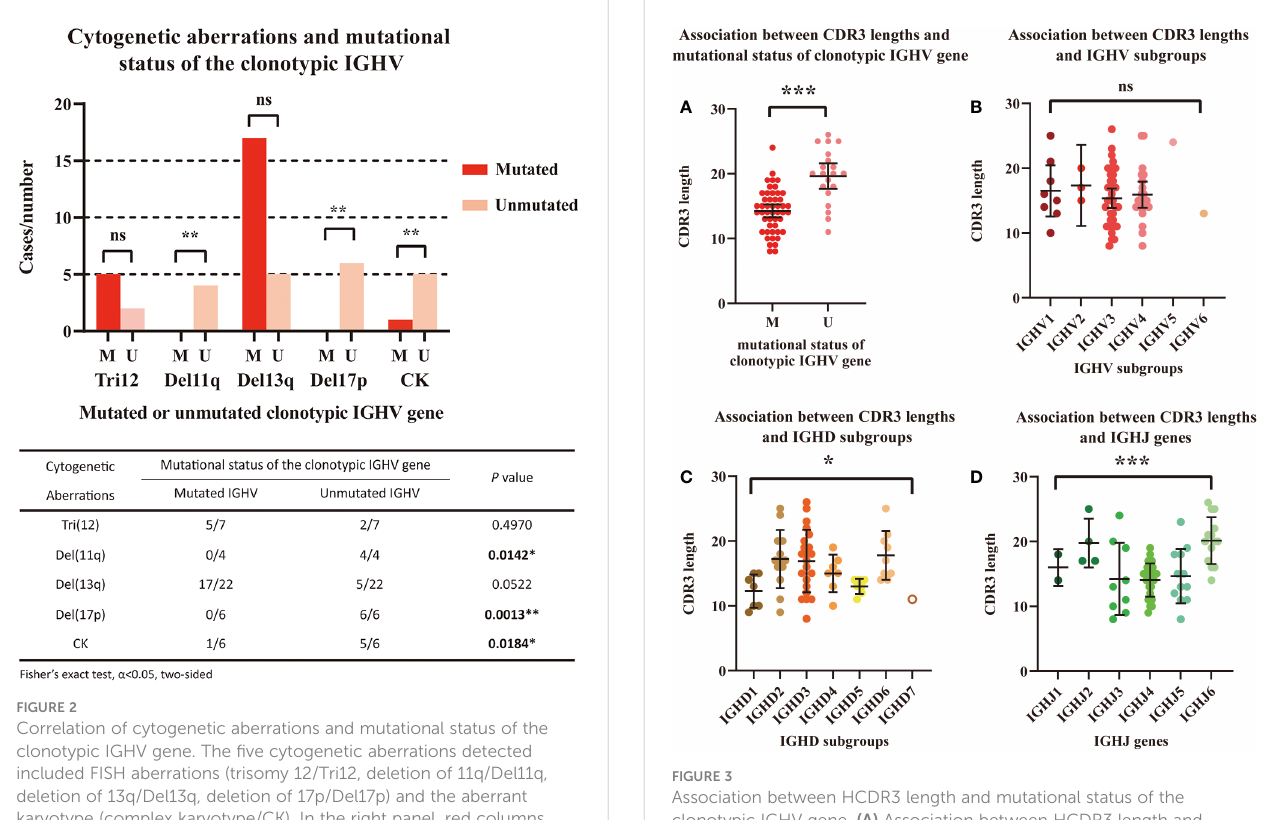
Table 4). Since the coverage of Panel 1 (genes: 3), Panel 2 (genes: 40) and Panel 3 (genes: 108) was incomplete, Figure 4A shows the frequency of gene mutations detected only by Panel 4 (genes: 129) and Panel5 (genes: 157). The distribution of mutated genes detected using Panel 4 or 5 and the corresponding mutation type are summarized in Figure 4B.